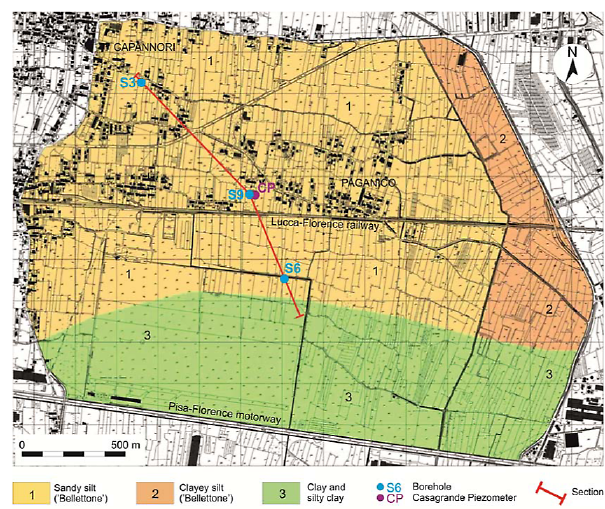
Fig. 2. Lithostratigraphic sketch map of the study area.